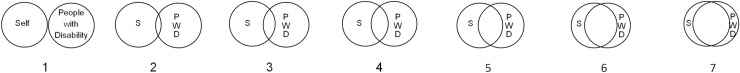
Self-other overlap with people with disability scale.Participants were asked to: Please select the pair of circles that best represents your relationship with people with disability. [S = Self, PWD = People with Disability].